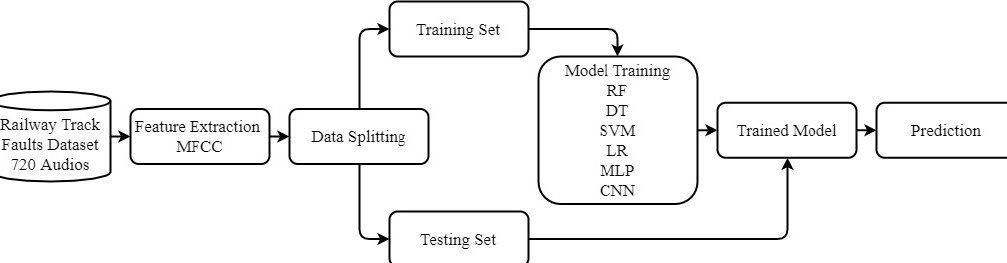
Figure 7. Architecture of the proposed methodology for faulty track detection comprising data collection, MFCC feature extraction, and training and testing the